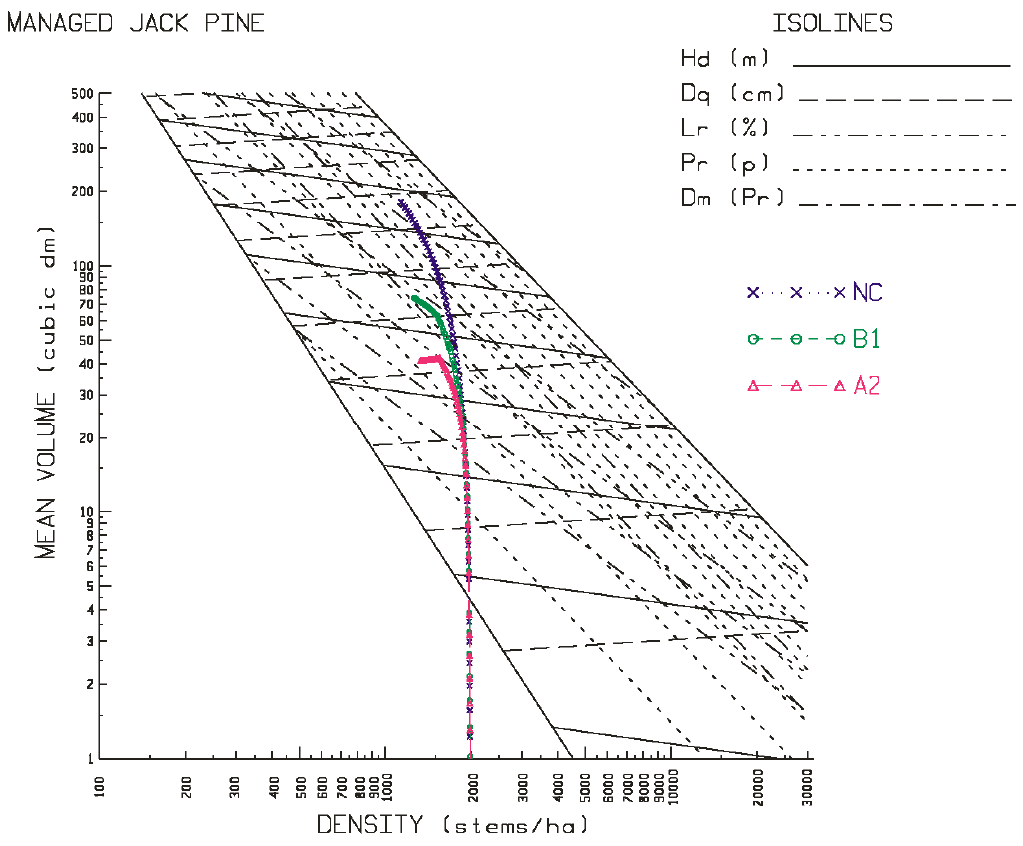
Figure 3. Temporal size ‐ density trajectories by scenario for jack pine plantations within the context of the SSDMM graphic for poor ‐ to ‐ medium quality sites ( S I = 8.6) within north ‐ western Ontario. Graphically illustrating: (1) isolines for mean dominant height (Hd; diagonal solid lines ranging from a minimum of 4 m at the bottom of the graphic to a maximum of 22 m at the top of the graphic separated by 2 m increments), quadratic mean diameter (Dq; horizontal long dashed lines ranging from a minimum of 4 cm at the bottom of the graphic to a maximum of 24 cm at the top of the graphic separated by 2 cm increments), mean live crown ratio (Lr; diagonal lines starting at the 35% (highest placed line) then 40% and thereafter at increasing 10% increments until 80% (lowest placed line)), and relative density index (Pr; 0.1 ‐ 1.0 by 0.1 intervals (short ‐ dashed diagonal lines)); (2) crown closure line (lower diagonal solid line) and self ‐ thinning rule at a Pr = 1.0 (upper diagonal solid line); (3) lower and upper relative density (Pr) diagonal isolines delineating the optimal density management window (Dm; 0.32 ≤ Pr ≤ 0.45); and (4) expected 75 year size ‐ density trajectories with 1 year intervals denoted for each scenario. Source: Modified SSDMM for jack pine.